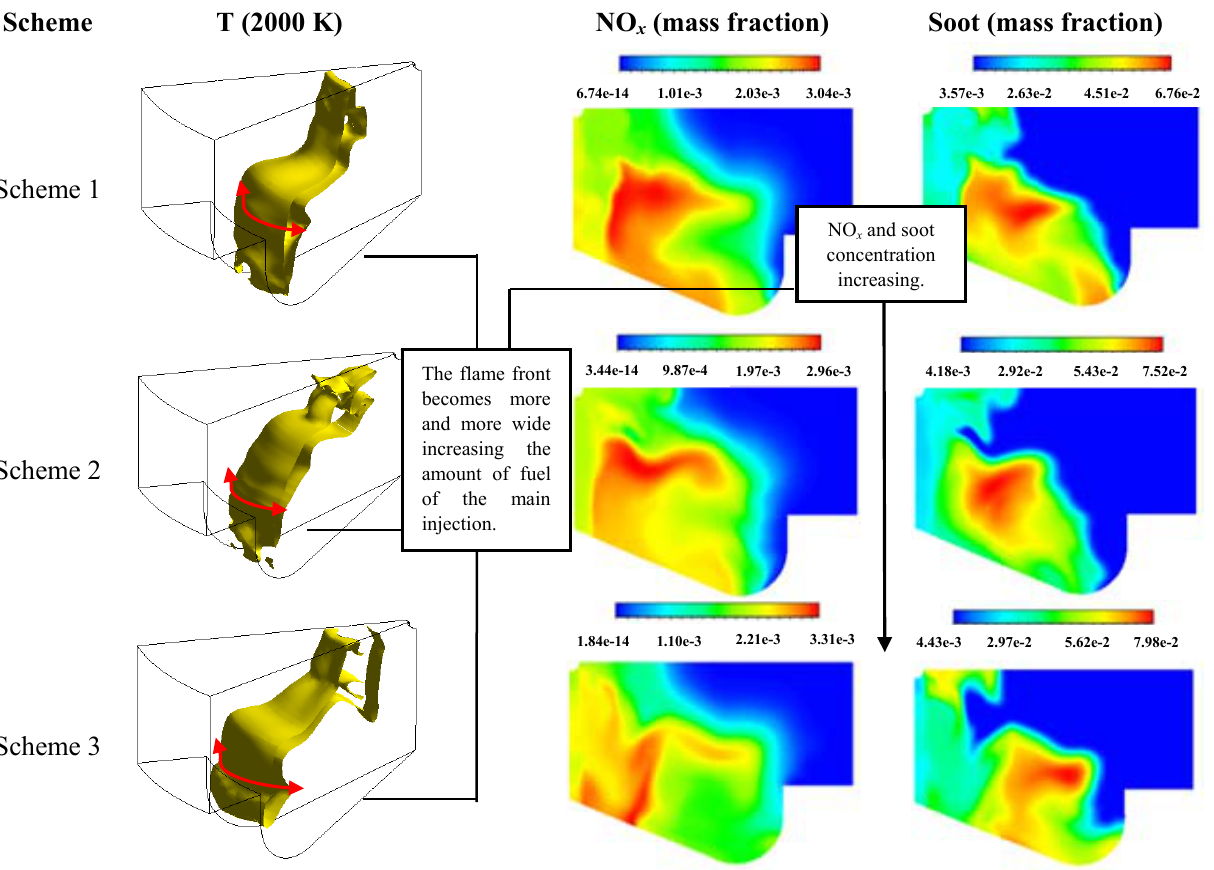
Figure 11. Iso-Temperature at 2000 K, NO Scheme T (2000 K) NO